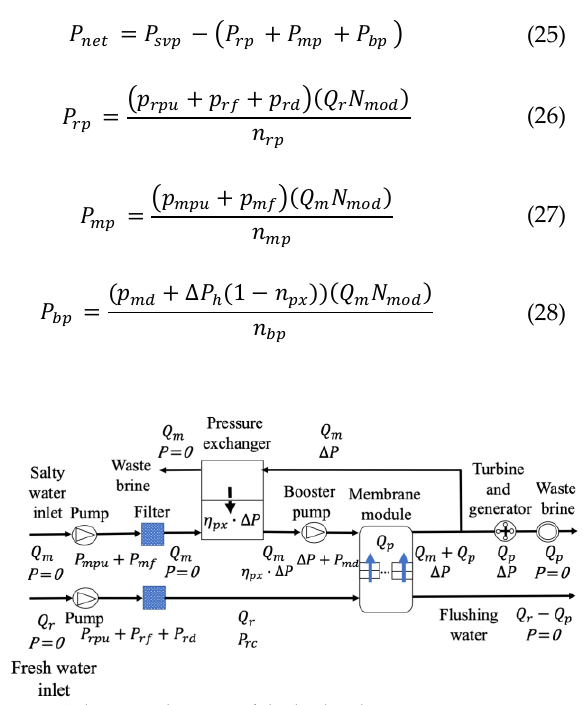
Fig. 4. Schematic diagram of the hydraulic